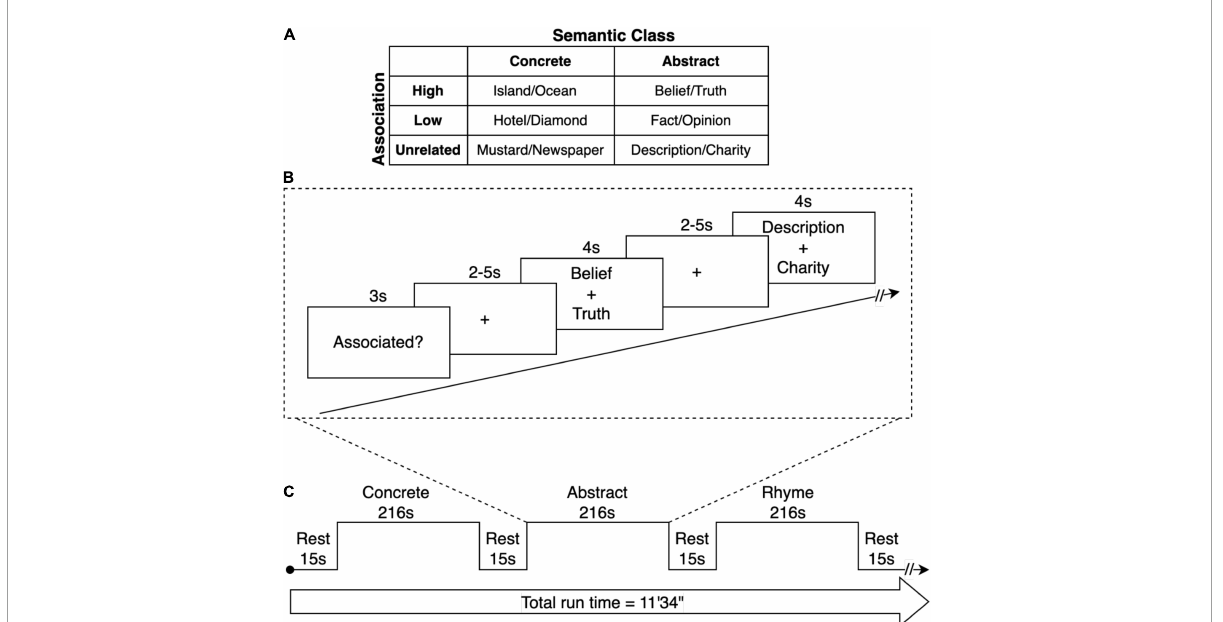
FIGURE1 fMRI Paradigm. (A) Semantic stimuli consisted of pairs of words with high- or low-associative relationship or that were unrelated. Each semantic condition contained an equal number of abstract and concrete word-pairs. The phonemic control condition contained rhyming or non-rhyming word-pairs. (B) Trials consisted of a sequence of visual stimuli for each condition. At the onset of each condition, a word was presented for 3 s that with the task demand (Associated? or Rhyme?). Subsequently, word-pairs were presented for 4 seconds. This was followed by a period during which participants responded with a binary button press depending on whether the word-pair was judged to be related (associated) or unrelated. For the phonemic condition, participants determined whether the words rhymed. The period after each word-pair presentation was of random duration of 2 and 5 s (jittered), providing a variable lag between trials to enable subsequent event-related analysis. (C) A repeating block sequence was presented alternating between the concrete, abstract, and rhyme word-pair conditions, each 216 s in duration, with a 15 s rest period between each